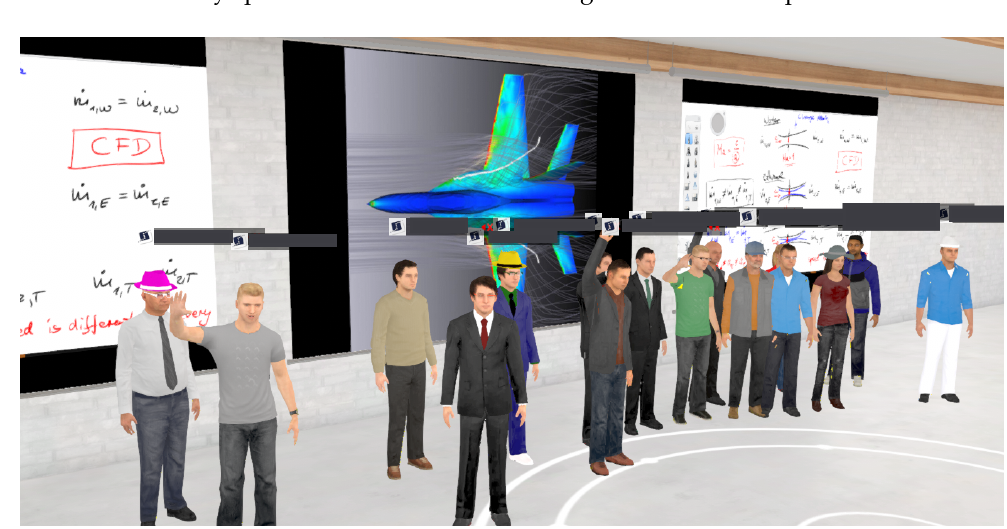
Figure 14. End of a class in LearnSpace, with images and whiteboards behind the